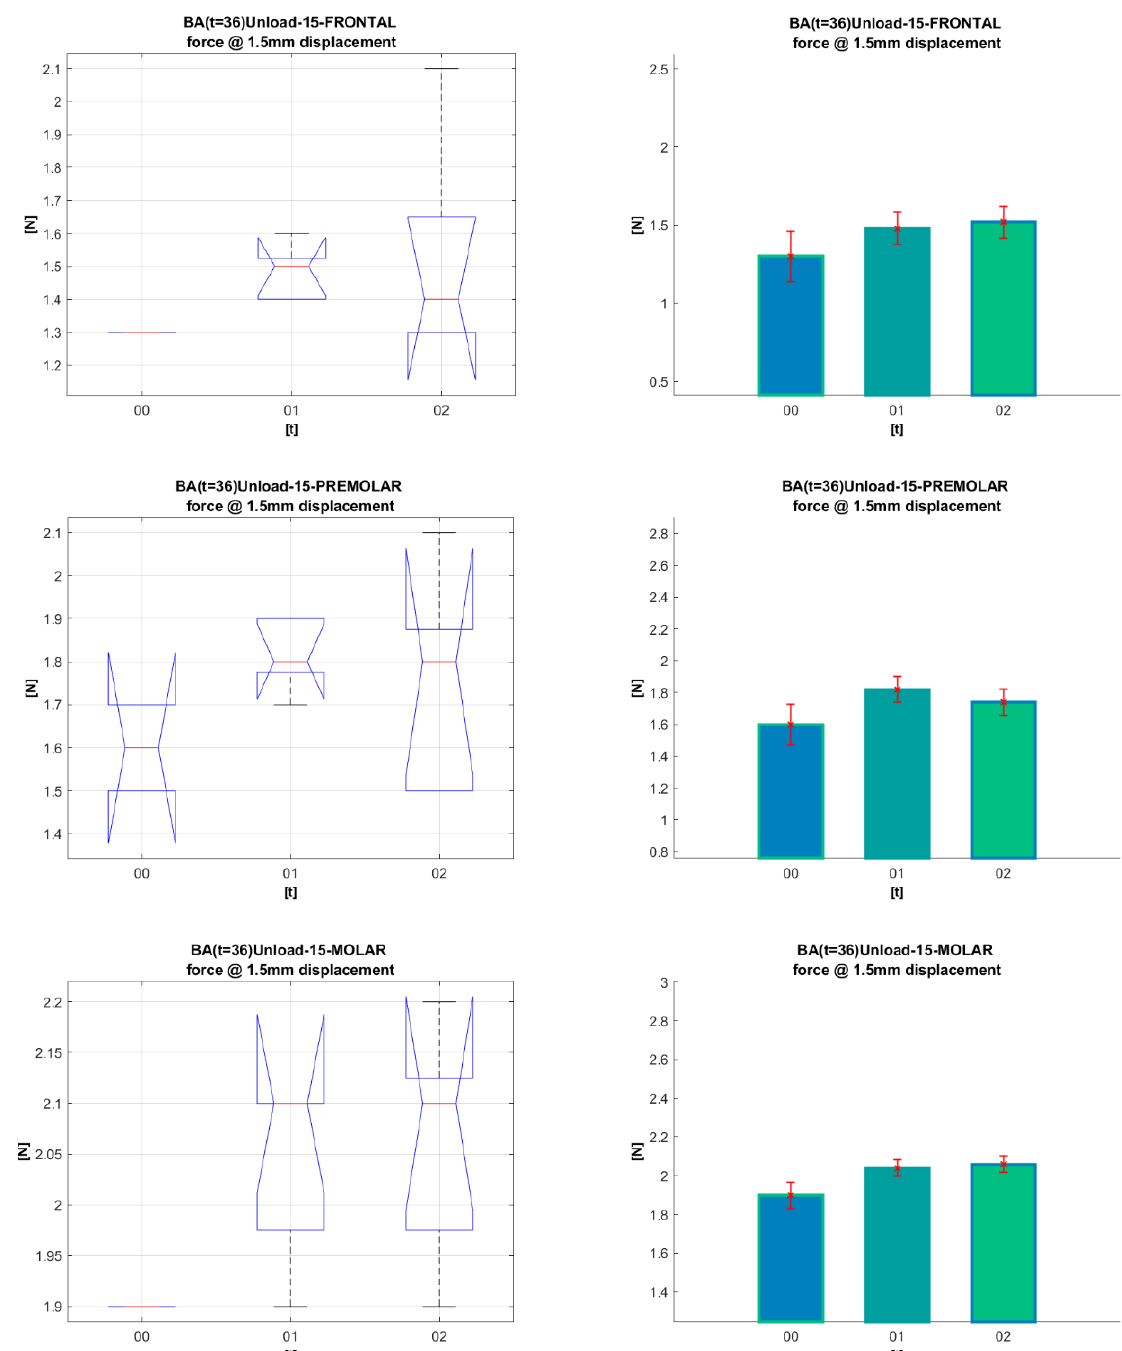
Figure 8. Statistic analysis for 1.5 mm deformation of Bio-Active ® archwires for periods (G 0 , G 1, G 2 ).